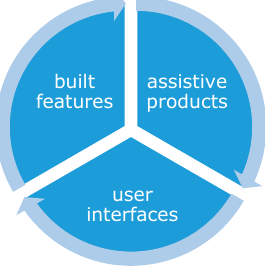
Figure 22. Three elements of integrated home technologies. Figure 2. Three elements of integrated home